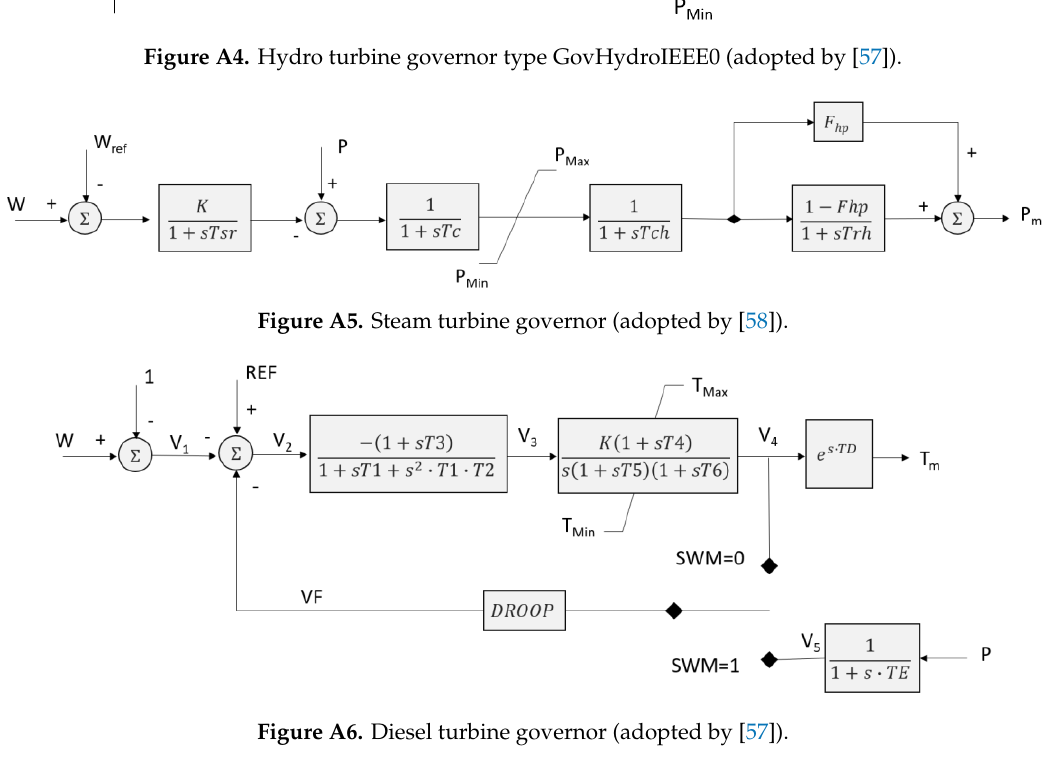
Figure A6. Diesel turbine governor (adopted by [57]).